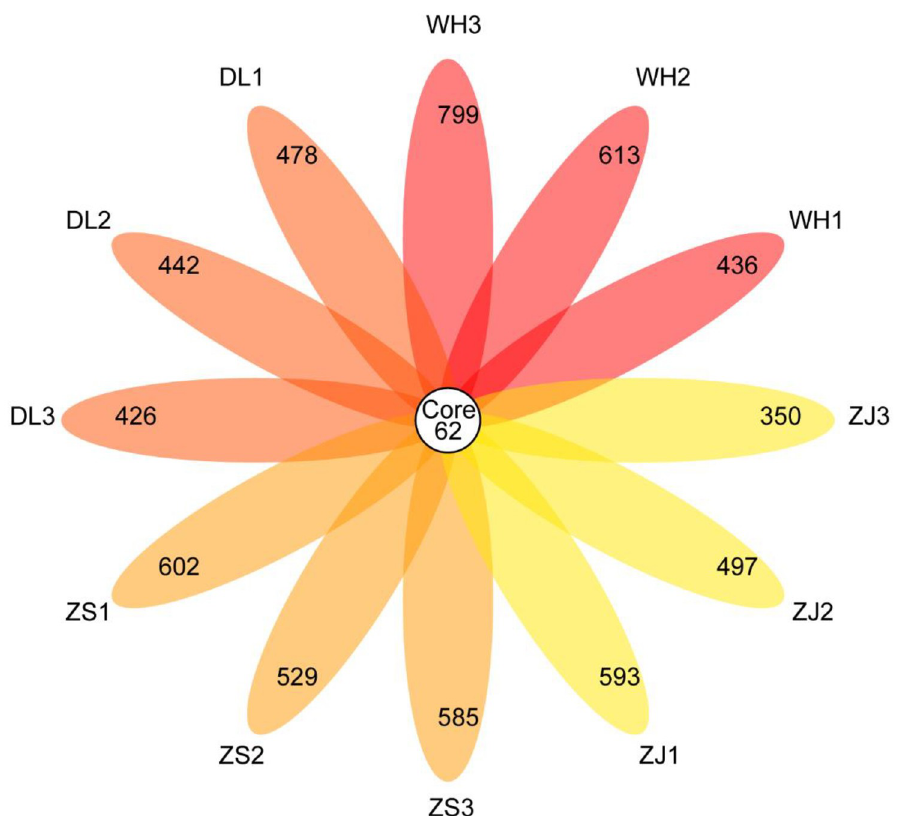
Fig 5. Venn plot showing overlapping OTUs across all the RPM